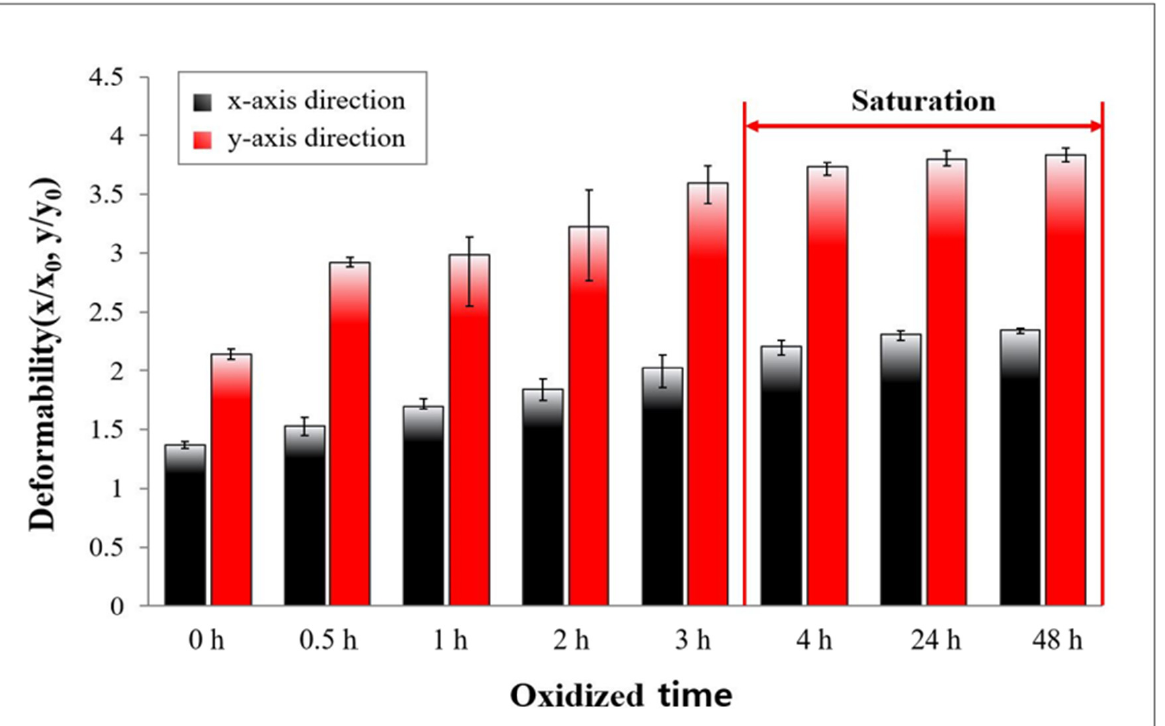
Figure 7. The deformation of liquid metal droplets in the x and y -axis direction, according to oxidation time.